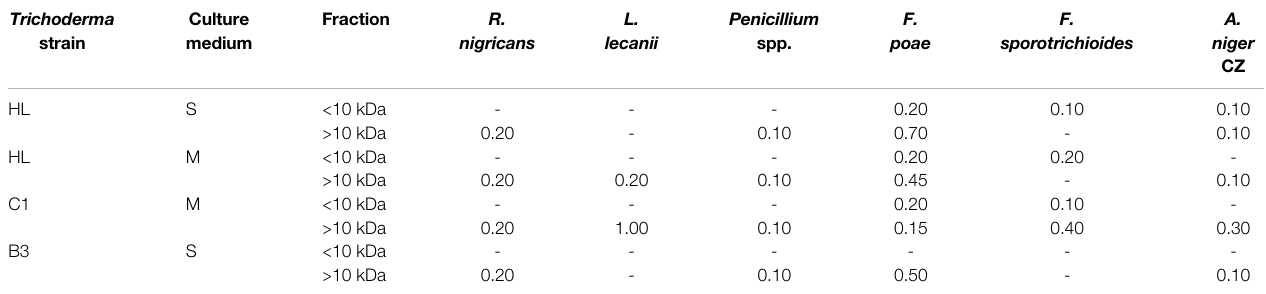
TABLE 3 | Clear zones diameter (cm) in inhibition test with foam fractions (F) after separation through ultra fi ltration. “ - ”— no inhibition, (M) MGP medium, (S) Saunders medium. E. nigrum and M. hiemalis did not produce inhibition zones. Trichoderma Culture Fraction L. strain medium